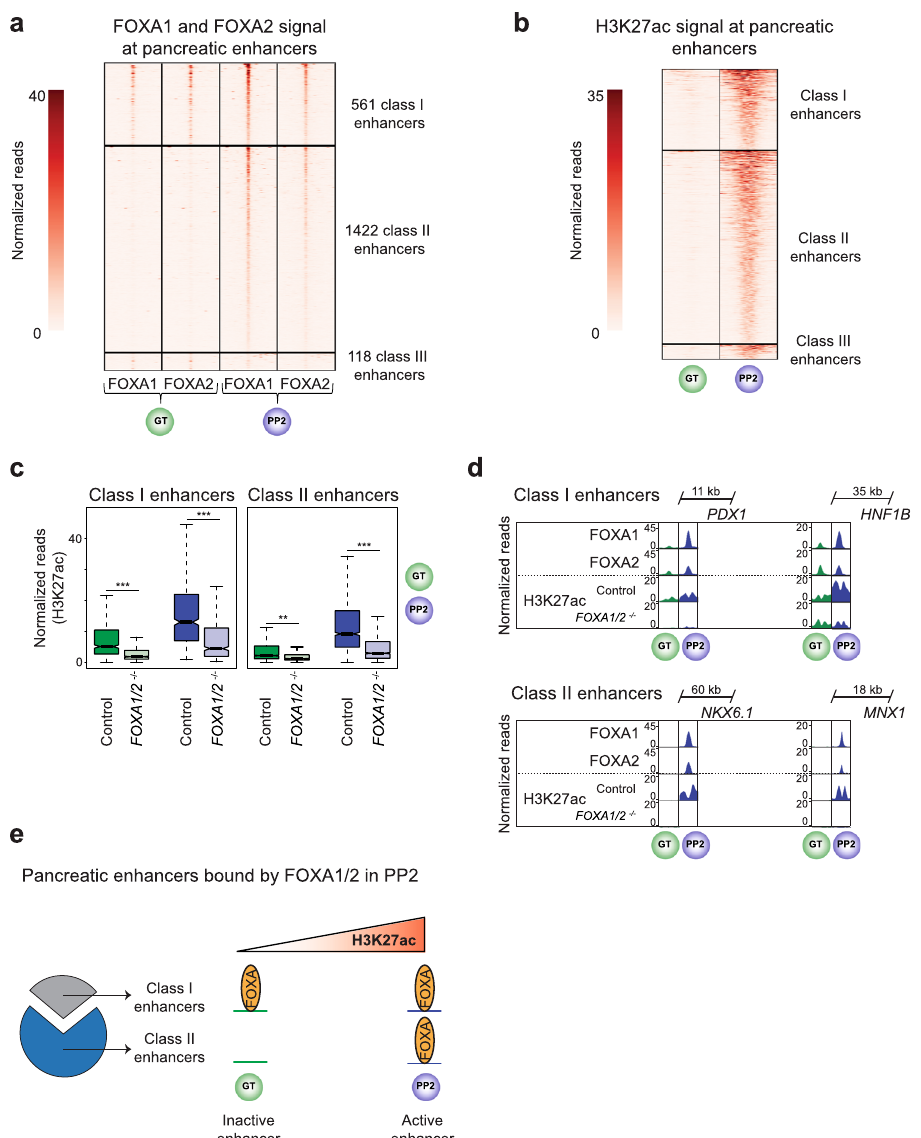
Fig. 2 Two distinct temporal patterns of FOXA1 and FOXA2 binding to pancreatic enhancers. a and b Heatmaps showing density of FOXA1 and FOXA2 ChIP-seq reads ( a ) and H3K27ac ChIP-seq reads ( b ) at pancreatic enhancers in GT and PP2. Heatmaps are centered on FOXA1, FOXA2, and H3K27ac peaks, respectively, and span 5 kb. Pancreatic enhancers are classi fi ed based on temporal pattern of FOXA1 and FOXA2 occupancy. c Box plots of H3K27ac ChIP-seq counts at class I and class II pancreatic enhancers in control and FOXA1/2 − / − GT and PP2 cells ( P = < 2.2 × 10 − 16 , <2.2 × 10 − 16 , 0.009, and <2.2 × 10 − 16 for control versus FOXA1/2 − / − at class I enhancers in GT, class I enhancers in PP2, class II enhancers in GT, and class II enhancers in PP2, respectively; Wilcoxon rank sum test, 2-sided). Plots are centered on median, with box encompassing 25th – 75th percentile and whiskers extending up to 1.5 interquartile range. d Genome browser snapshots showing FOXA1, FOXA2, and H3K27ac ChIP-seq signal at class I pancreatic enhancers near PDX1 and HNF1B and class II pancreatic enhancers near NKX6.1 and MNX1 in GT and PP2. Approximate distance between enhancer and gene body is indicated. e Schematic illustrating the identi fi ed pattern of FOXA1/2 occupancy at pancreatic enhancers. All ChIP-seq experiments, n = 2 replicates from independent (Fig. 4a and Supplementary Data 11). Work in model organisms has identi fi ed critical roles for ETS TFs as well as Hippo and retinoic acid signaling in early pancreatic development 22 – 25 , suggesting that pancreatic lineage-inductive signals are read at class I enhancers by partnering of FOXA1/2 with signal- dependent TFs. ChIP-seq analysis for RXR con fi rmed pre- the PP1 stage (Fig. 4b). Class I enhancers were also enriched for